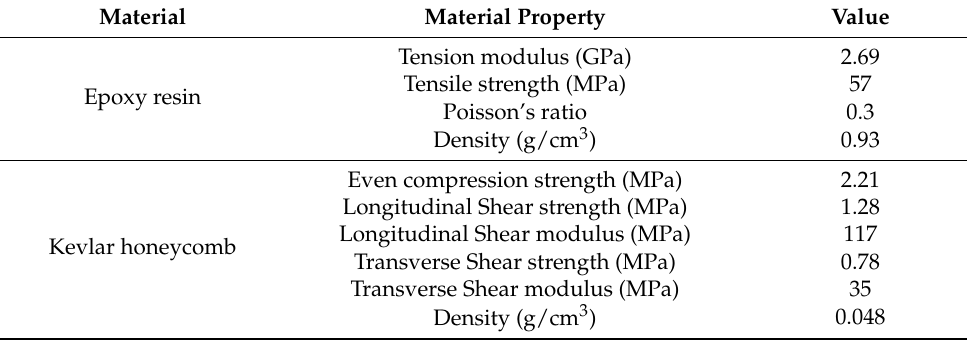
Figure 9. ( a ) The production process of honeycomb [28] and ( b ) bendable aramid auxetic honeycomb. Table 1. Material properties of epoxy resin and honeycomb.